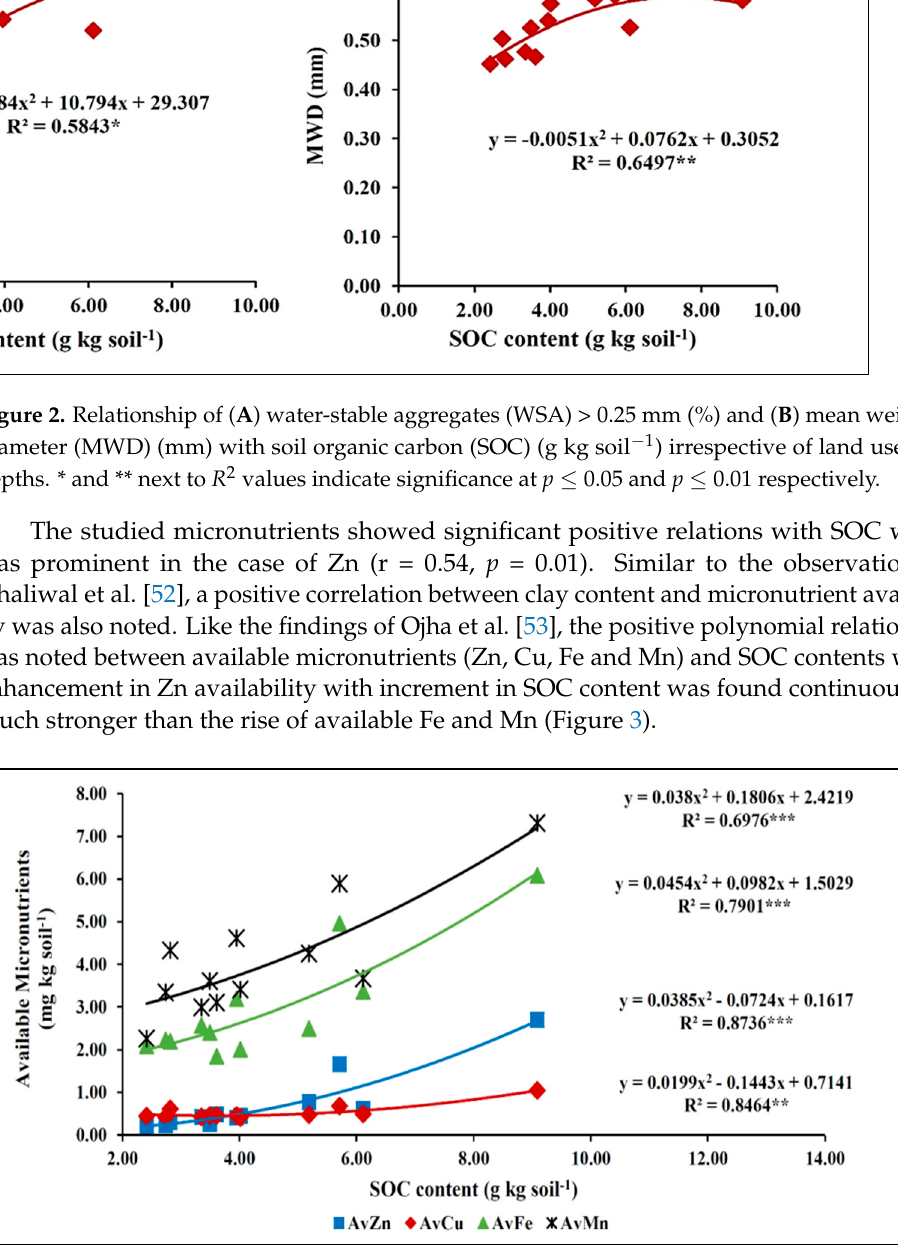
Figure 3. Relationship of Available Micronutrients (mg kg soil − 1 ) with soil organic carbon (SOC) (g kg soil − 1 ) irrespective of land uses and depths. ** and *** next to R 2 values indicate significance at p ≤ 0.01 and p ≤ 0.001 respectively.